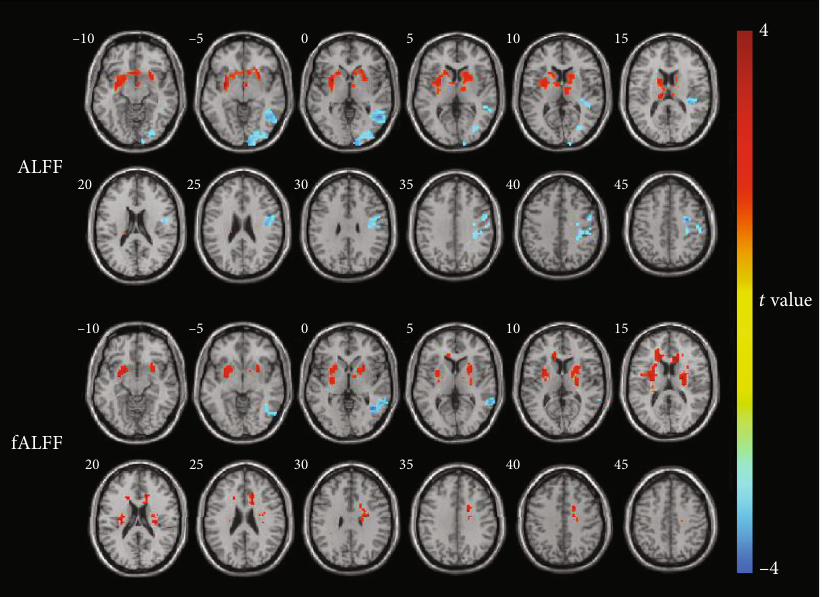
Figure 1: Intergroup comparison of ALFF and fALFF between the SSNHL and HC groups. The ALFF value of the SSNHL group was signi fi cantly increased in a cluster located in the left putamen but was decreased in three clusters located in the right calcarine cortex, right MTG, and right precentral gyrus compared with the HC group. The fALFF value in the SSNHL group was signi fi cantly increased in two clusters located in the right and left putamen but was decreased in a cluster located in the right MTG. Signi fi cantly increased ALFF or fALFF values are indicated in red, while signi fi cantly decreased ALFF or fALFF values are indicated in blue. Table 2: The peak MNI coordinates and intensity of brain clusters with signi fi cant intergroup di ff erences in ALFF and fALFF. Brain region MNI coordinates x , y , and z Number of voxels Peak intensity Increased